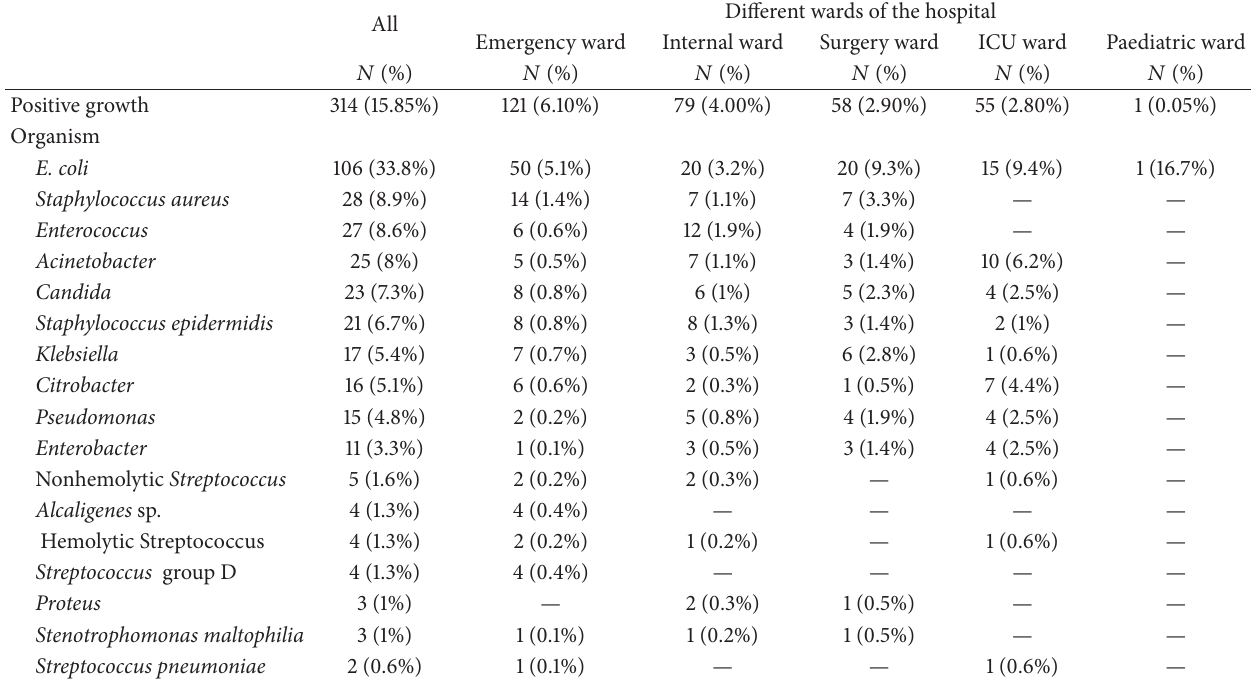
Table 1: Profiles of the isolated microorganisms in spontaneous bacterial peritonitis in different wards.